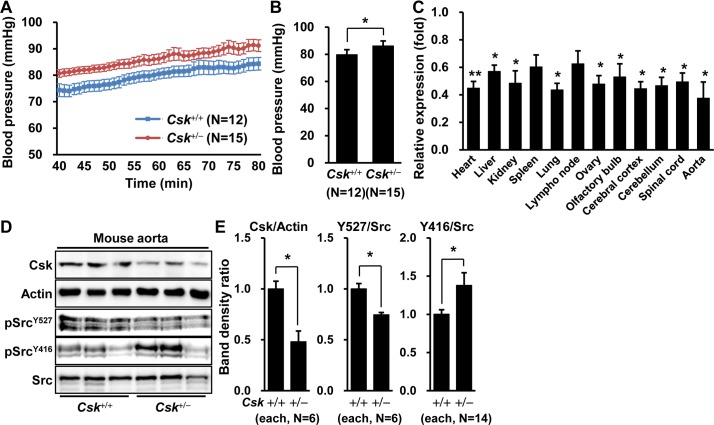
Increase in blood pressure in Csk+/- mice.(A, and B) Blood pressure is expressed as (A) the average value at each minute and (B) the mean blood pressure for each group from 40 min to 80 min after anesthesia in Csk+/- and the wild-type. (C) The relative expression of Csk mRNA in each tissue is expressed as the fold change of relative levels in Csk+/- (N = 7) versus Csk+/+ (N = 5), normalized by Gapdh. (D) The representative blots of Csk and phosphorylated Src protein levels are shown following Western blotting in aorta of Csk+/- and Csk+/+ mice. (E) Protein levels in aorta are presented as the ratio of band densities for Csk+/- mice to those for Csk+/-. Number in parentheses indicates the number of mice used for the Western blotting.